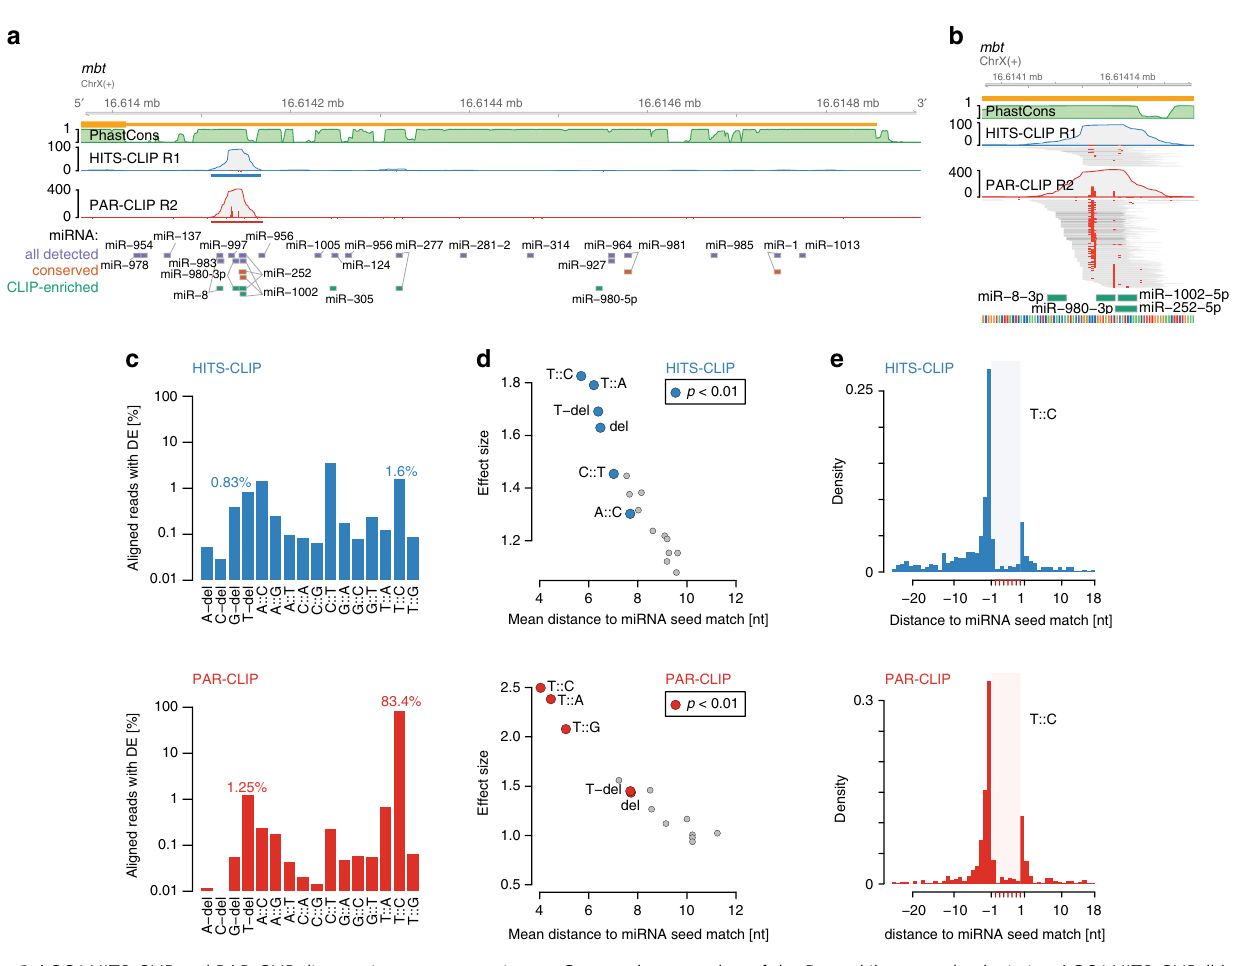
Fig. 2 AGO1 HITS-CLIP and PAR-CLIP diagnostic event comparison. a Genome browser shot of the Drosophila gene mbt , depicting AGO1 HITS-CLIP (blue) and PAR-CLIP (red) coverage tracks along its 3 ′ UTR as well as 27way PhastCons scores (green). Blue and red bars indicate IDR-selected peak calls. Below, 7mer and 8mer seed matches for all miRNA in TargetScan 6.2 (conserved and non-conserved families), conserved miRNA (predicted conserved targets), and top 59 CLIP-enriched miRNA (see Supplementary Figure 1A) are indicated ( y -axis shows the number of detected CLIP reads). b Similar to ( a ), genome browser shot of HITS-CLIP and PAR-CLIP peak in mbt 3 ′ UTR including alignments. Red squares in individual read alignments indicate T-to-C mismatches to the dm6 reference. Red bars within coverage tracks indicates the T-to-C conversion proportion at nucleotide resolution. Below, 7mer/8mer seed matches of CLIP-enriched miRNAs are indicated. c Percentages of diagnostic events relative to all uniquely aligning reads. d Results according to Supplementary Figure 2M. Scatterplot of mean distance to miRNA start ( x -axis) relative to its effect size ( y -axis). e T-to-C conversion example according to ( d ). Density of T-to-C conversion positional maxima relative to unique 7mer or 8mer matches in top 3000 IDR-selected 3 ′ UTR